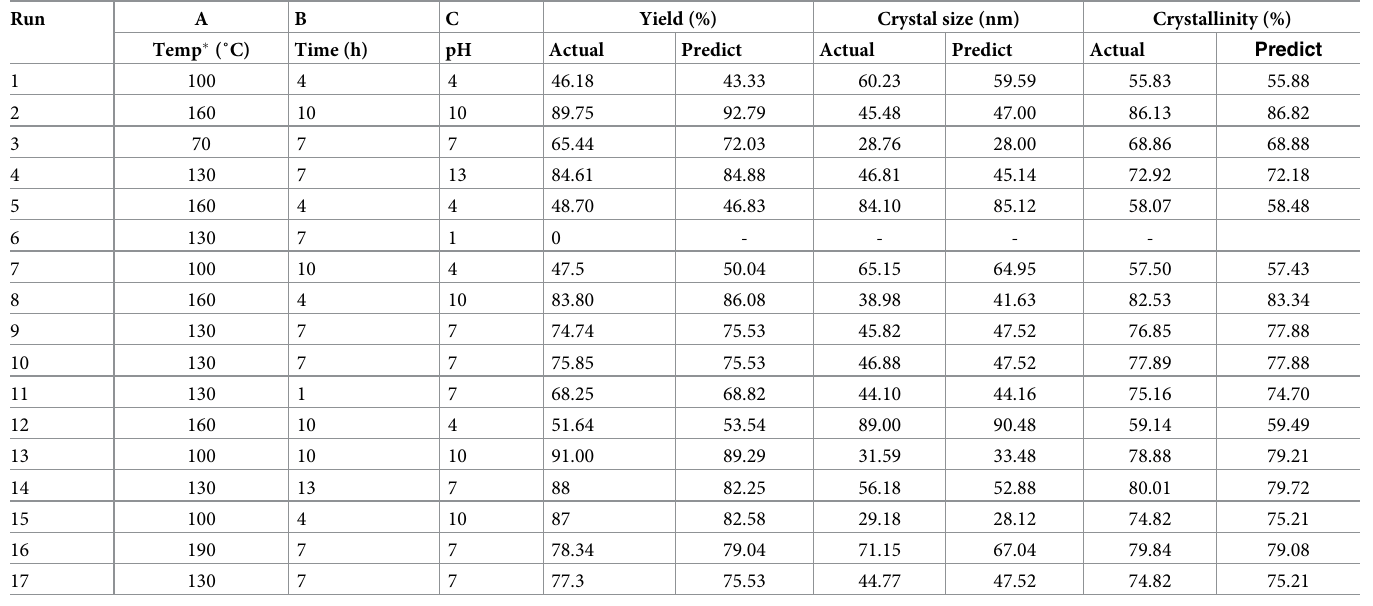
Table 4. Design of Central Composite Design (CCD) and its actual